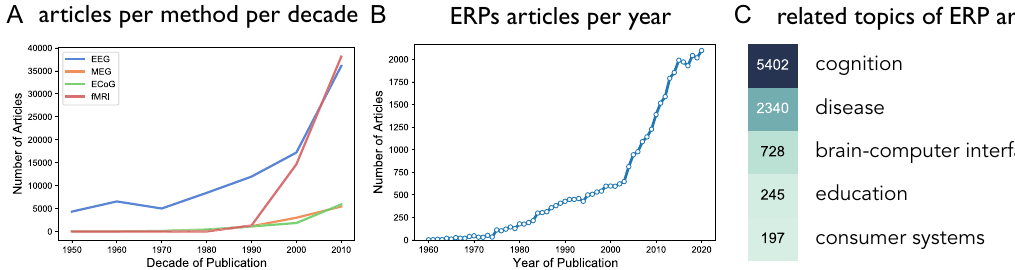
Figure 1. Prevalence of ERP research. ( A ) The number of articles across different methods for measuring brain activity, across decades. Note that each x-axis label reflects a decade (eg. “1950” reflects 1950–1959). ( B ) The number of articles on the topic of ERPs per year, measured as papers using the terms "event related potential", “ERP”, or “evoked potential”. ( C ) The number of ERP articles related to different topics, based on co-occurrence of ERP terms and listed association